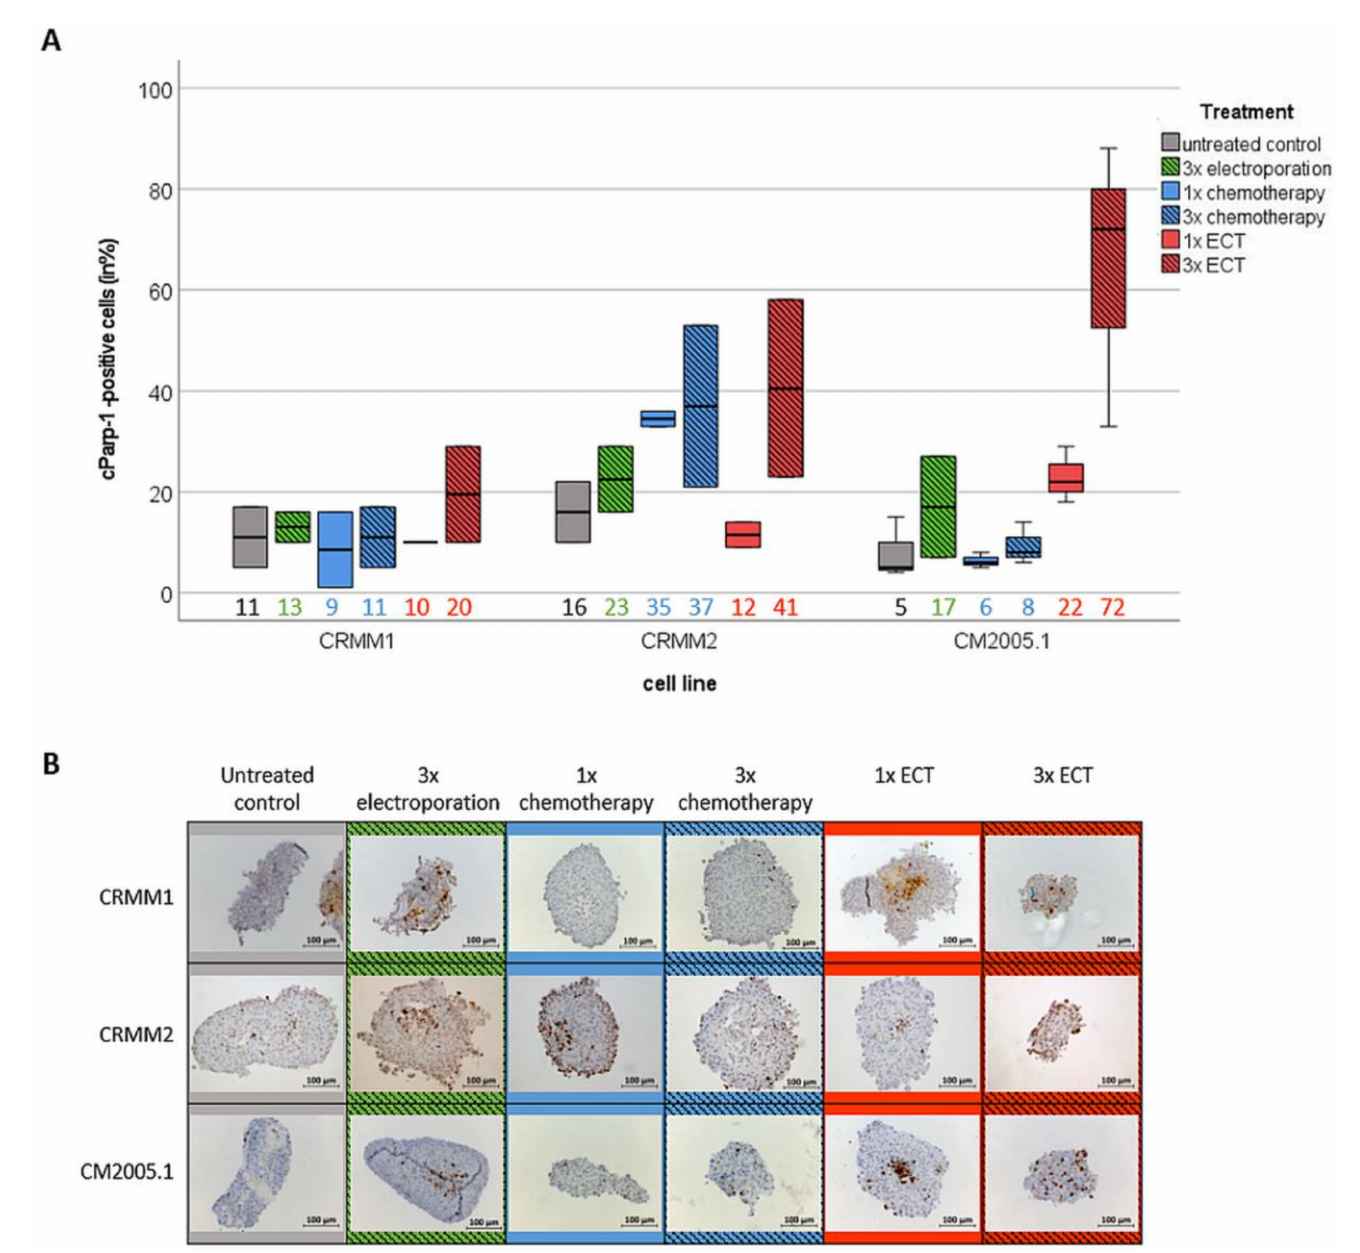
Figure 5. Quantitative analyses of apoptotic cells using cParp-1 staining in cross sections of tumor spheroids on day 7 after different treatment options. ( A ) Boxplot of cParp-1 positive cells in cross sections of tumor spheroids after different treatment options. Median values are listed on the bottom side of the boxplot; ( B ) Representative images of immunocytochemically stained spheroids after different treatment options. Scale bar = 100 µ m. Abbreviation: ECT =